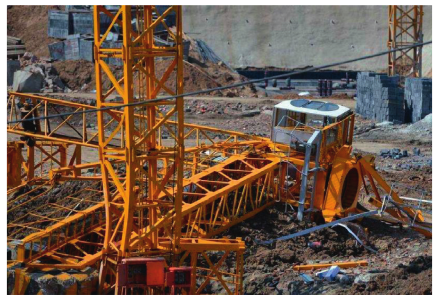
Figure 2: Collapsed tower